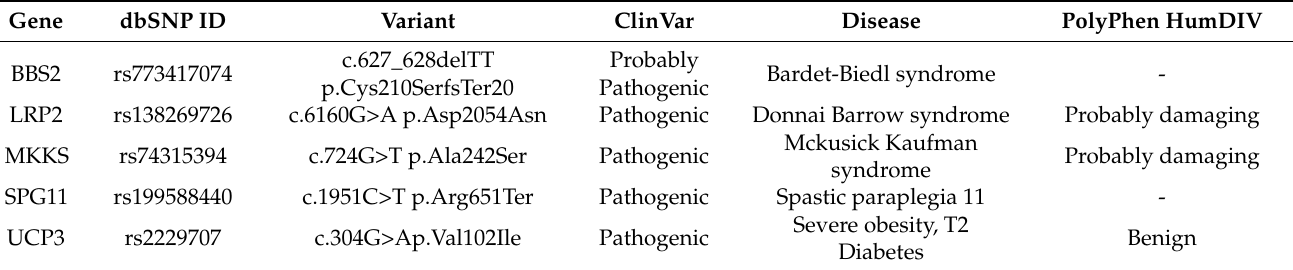
Table 7. Pathogenic or probably pathogenic variants